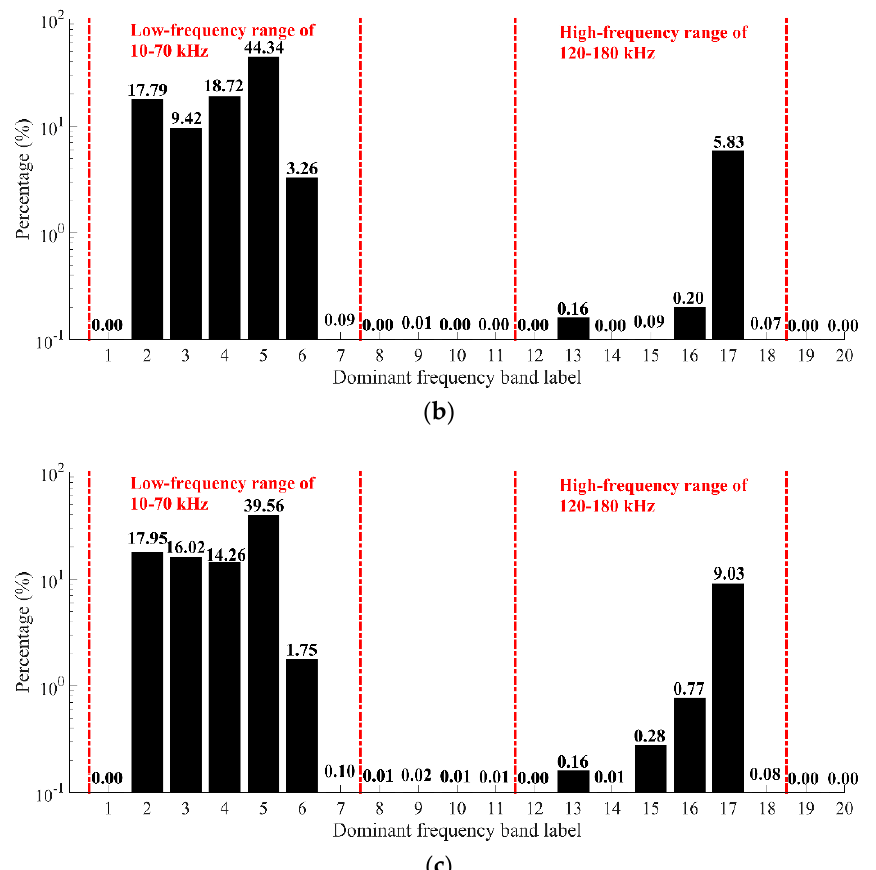
Figure 4. Dominant frequency characteristics of specimens. ( a ) X-1 specimen; ( b ) X-3 specimen; ( c ) X-6 specimen.